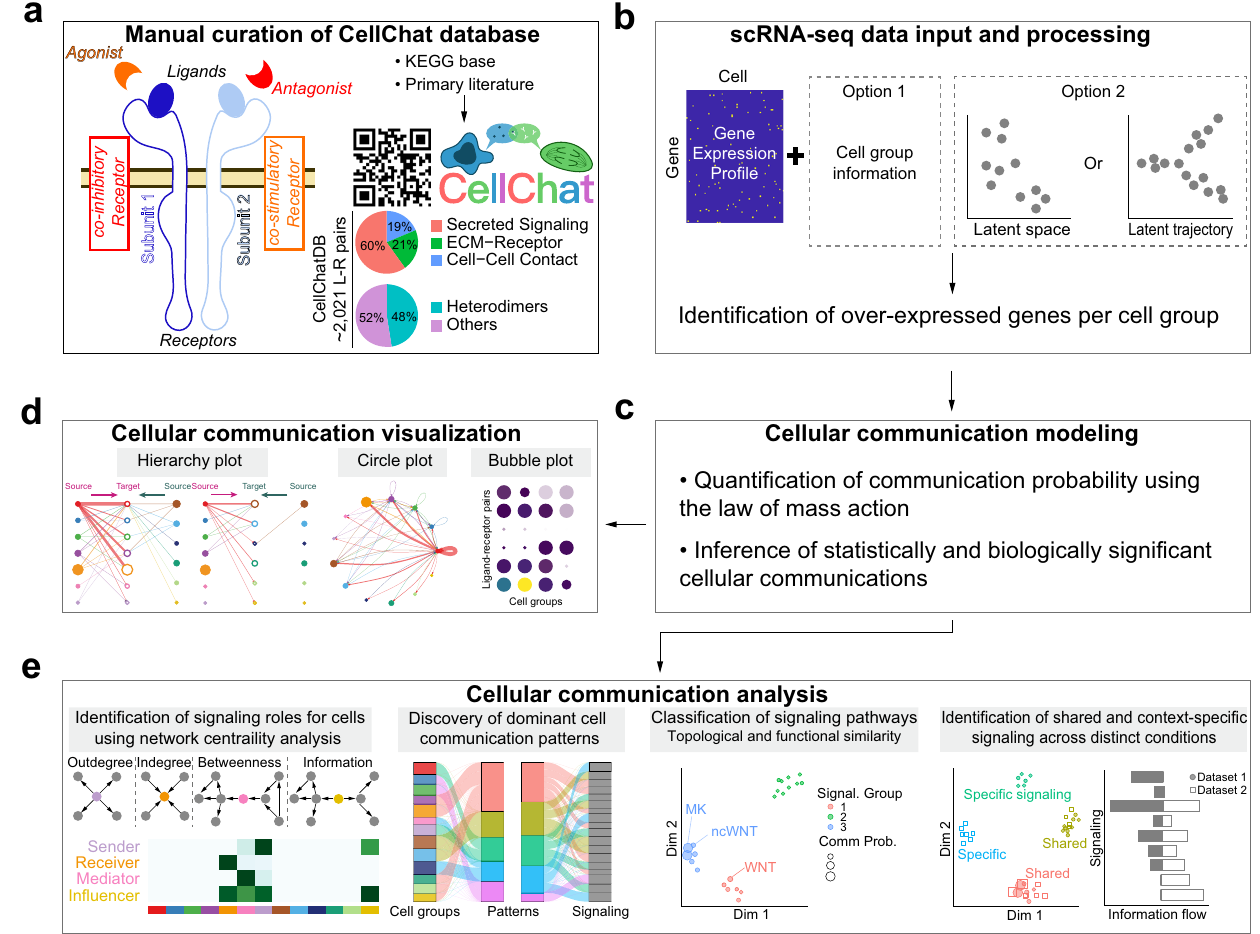
Fig. 1 Overview of CellChat. a Overview of the ligand-receptor interaction database. CellChatDB takes into account known composition of the ligand- receptor complexes, including complexes with multimeric ligands and receptors, as well as several cofactor types: soluble agonists, antagonists, co-stimulatory and co-inhibitory membrane-bound receptors. CellChatDB contains 2021 validated interactions, including 60% of secreting interactions. In addition, 48% of the interactions involve heteromeric molecular complexes. b CellChat either requires user assigned cell labels as input or automatically groups cells based on the low-dimensional data representation supplied as input. c CellChat models the communication probability and identi fi es signi fi cant communications. d CellChat offers several visualization outputs for different analytical tasks. Different colors in the hierarchy plot and circle plot represent different cell groups. Colors in the bubble plot are proportional to the communication probability, where dark and yellow colors correspond to the smallest and largest values. e CellChat quantitatively measures networks through approaches from graph theory, pattern recognition and manifold learning, to better facilitate the interpretation of intercellular communication networks and the identi fi cation of design principles. In addition to analyzing individual dataset, CellChat also delineates signaling changes across different contexts, such as different developmental stages and biological